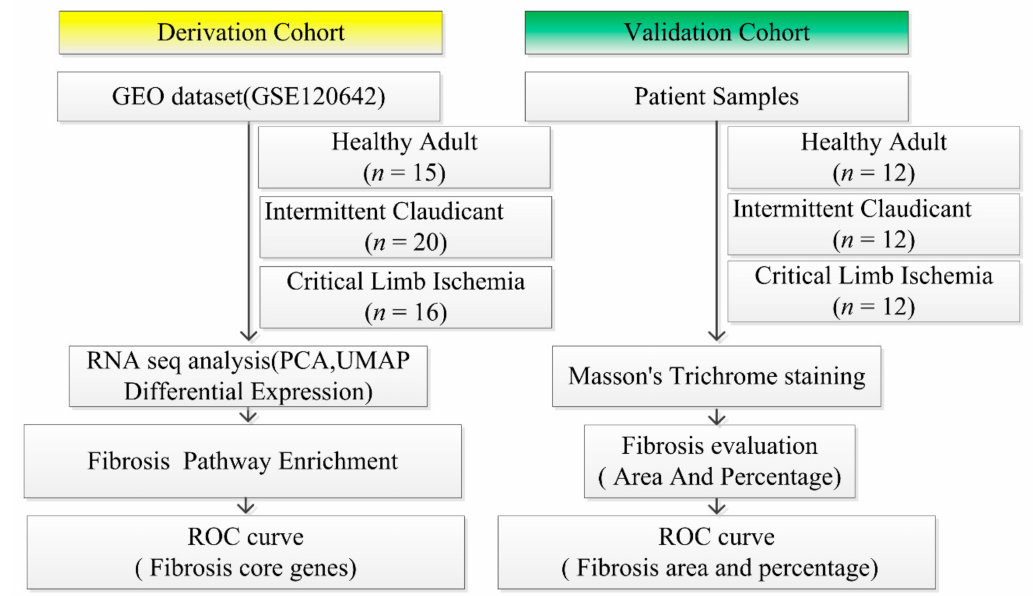
Figure 1. Flow Diagram of Study design and data processing. RNA sequence data of 51 skeleton muscle biopsies in peripheral arterial disease (PAD) (16 of critical limb ischemia (CLI) and 20 of